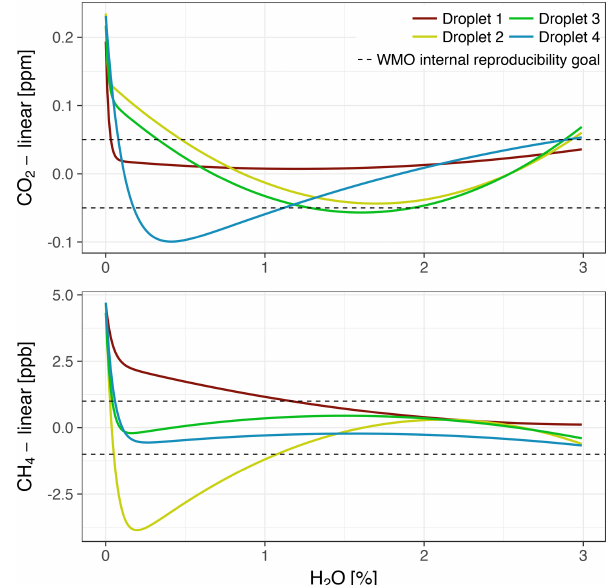
Figure 11. Expanded water correction model fitted to data from four droplet experiments with Picarro no. 1. To emphasize the large differences, a common linear component has been subtracted. The dashed lines are the same as in Fig.